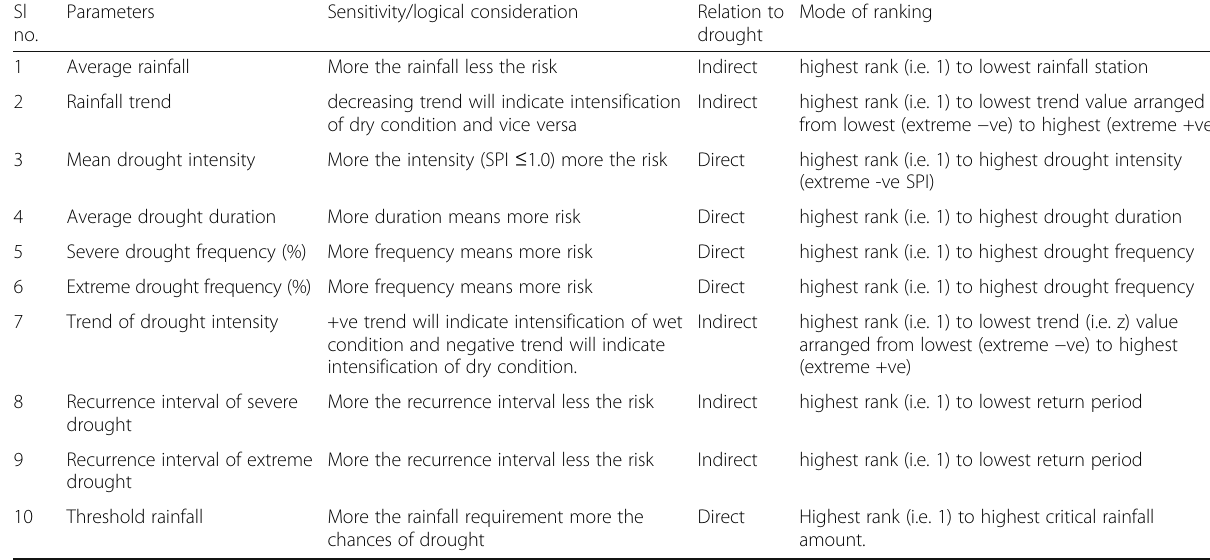
Table 2 List of selected parameters and their modes of ranking of the parameters for CDRI Sl